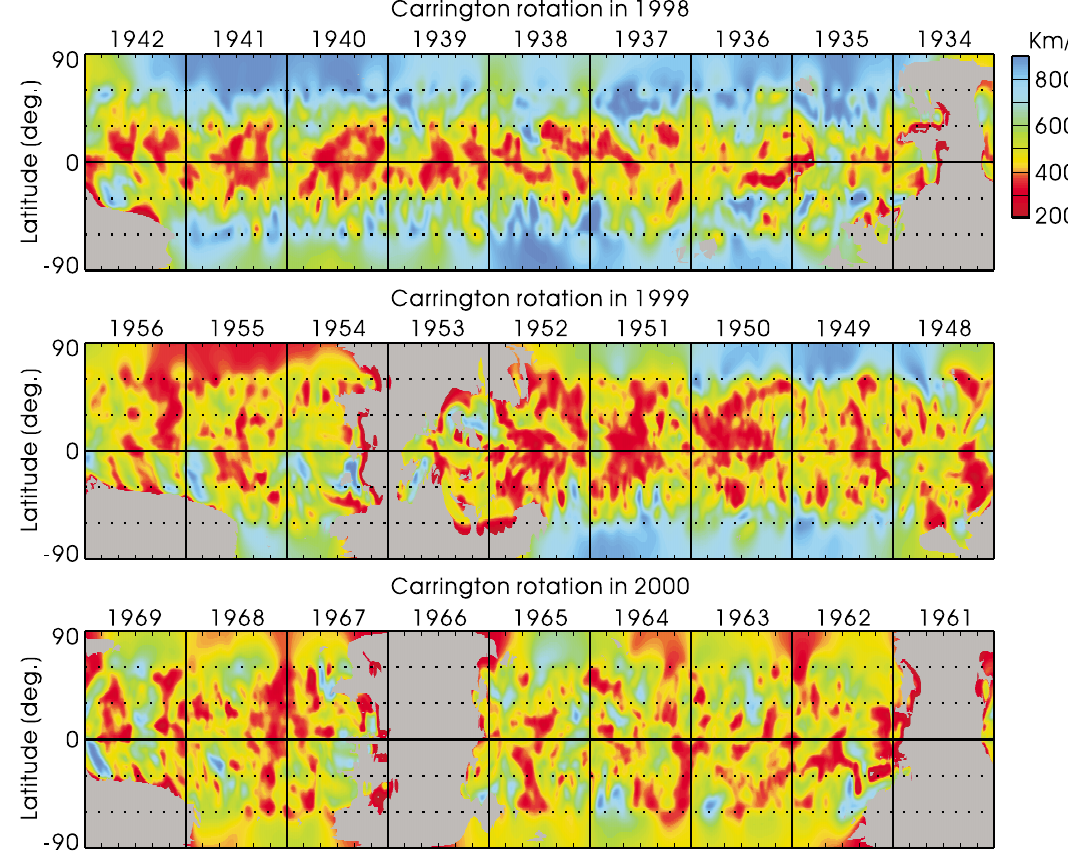
Fig. 2. Solar wind velocity structure around the solar maximum. Top to bottom panels show continuous variation of solar wind structure in the years from 1998 to 2000. Gray regions are data gap.